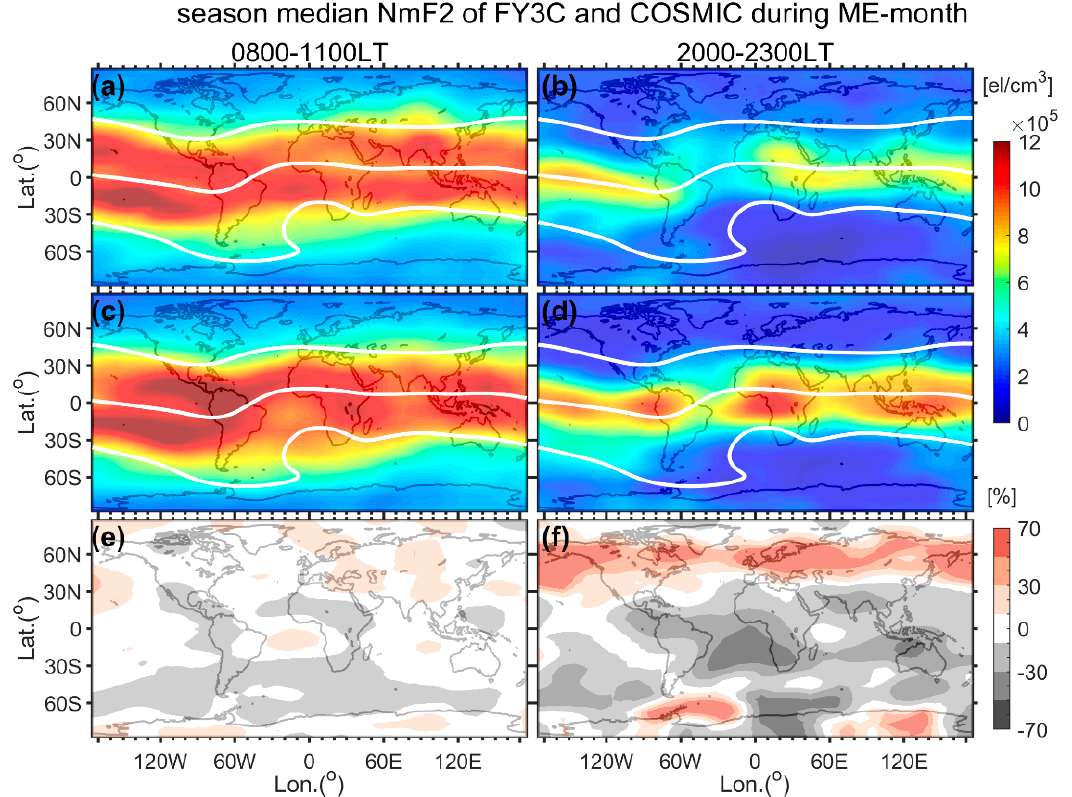
Figure 6. Ionospheric climatological characteristics of season median NmF2 observed by FY3C / GNOS and COSMIC and their di ff erences at 0800–1100LT and 2000–2300LT during ME-month ( ± 45 days to March equinox of 2016) from 2016.035 to 2016.125. ( a , b ) The climatological characteristics of season median NmF2 observed by FY3C / GNOS at 0800–1100LT and 2000–2300LT, respectively. ( c , d ) The climatological characteristics of season median NmF2 probed by COSMIC at 0800–1100LT and 2000–2300LT, respectively. The dip contours in (a–d) are represented by white curves, which are 60 ◦ dip, 0 ◦ dip, − 60 ◦ dip from top to bottom, respectively. ( e , f ) The relative errors of season median NmF2 between FY3C / GNOS and COSMIC at 0800–1100LT and 2000–2300LT, respectively. The acquisition of NmF2 relative error can be seen in Section 2.2.